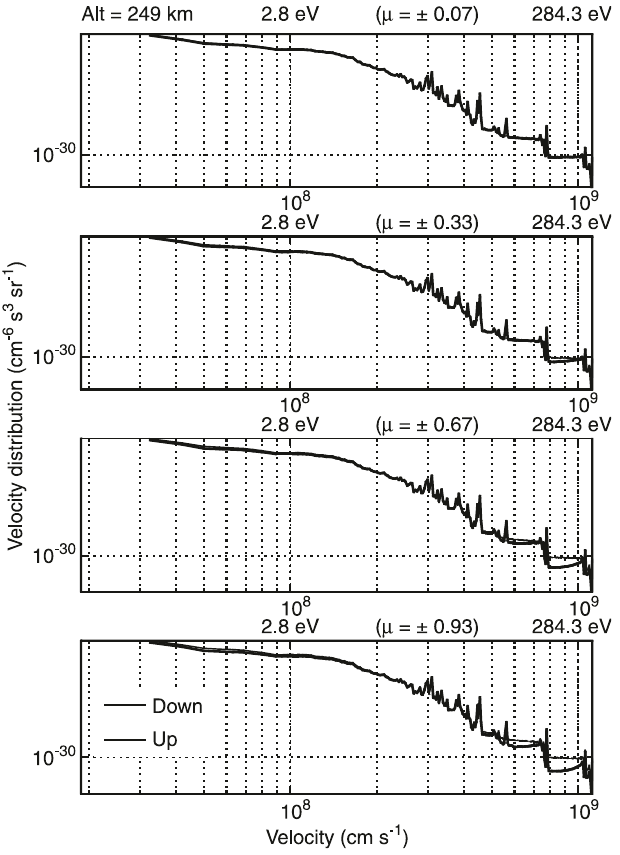
Fig. 3. The suprathermal angular velocity distribution function for the same eight-stream calculation at 249 km. Each plate contains two curves corresponding to two angles symmetric around the direction perpendicular to the magnetic field, i.e the upward angular flux ( thin solid line ) and the downward one ( thick solid line ). The upper horizontal scale on each plate is energy expressed in eV